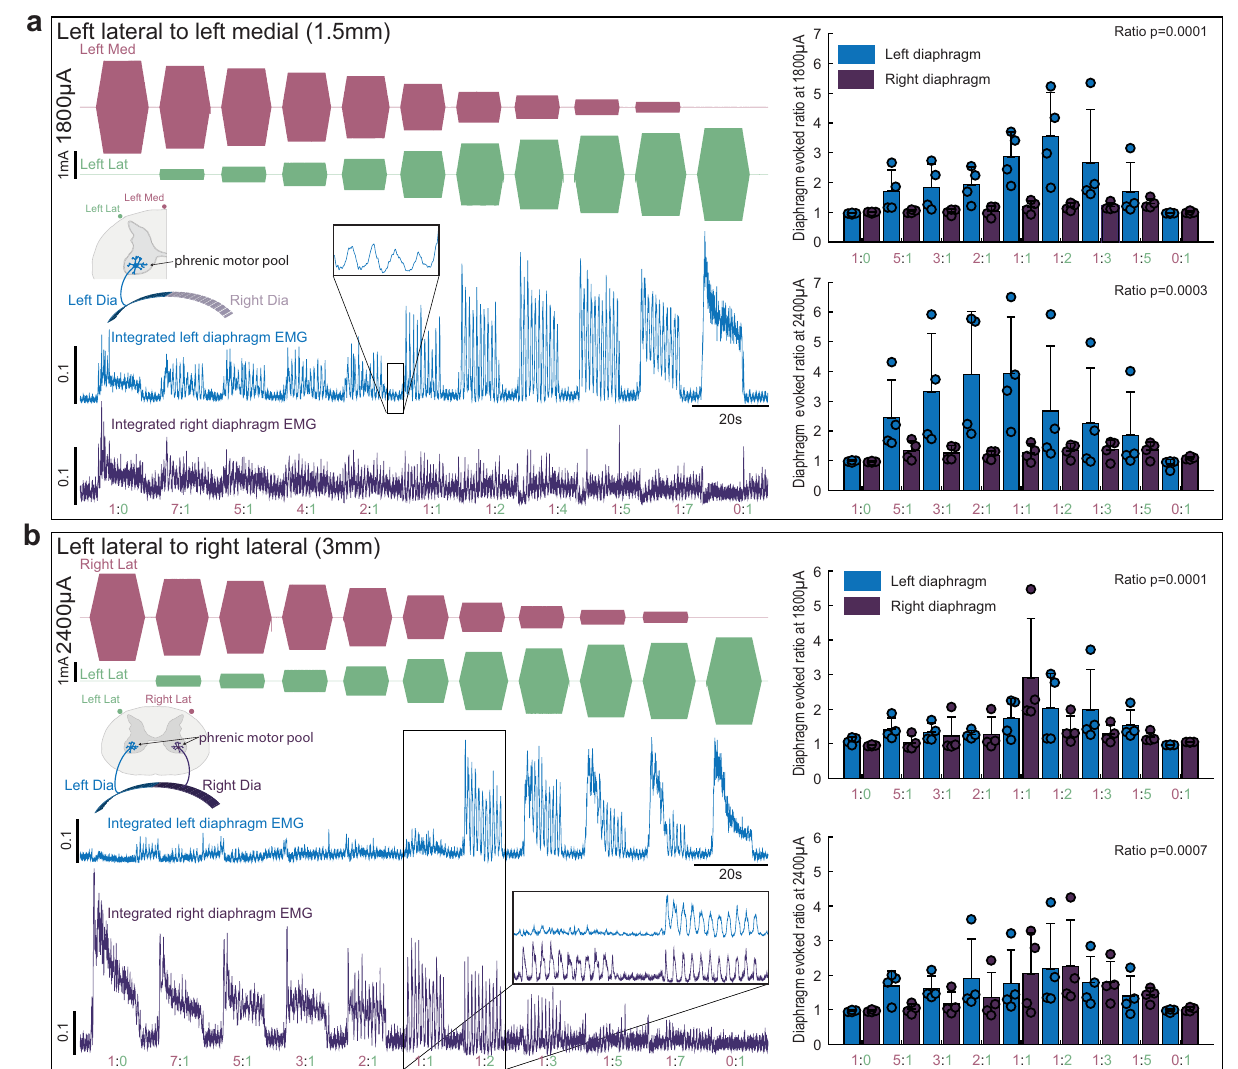
Fig. 4 Current steering during epidural TI stimulation. Using diaphragm EMG as the outcome measure, the steerability of the TI focal point was examined by varying the ratio of the two stimulus currents using two inter-electrode distance. Stimulating electrodes were placed on the left side of the spinal cord ( a , 1.5 mm apart) or spanning the dorsal surface ( b ; 3 mm apart). The left side of panel a shows an example of recti fi ed and integrated diaphragm activity when TI was delivered with lateral electrode placement and a current sum of 1800 µ A. In this example it can be appreciated that varying the TI current ratio dramatically alters the magnitude of phasic diaphragm activation, and tonic diaphragm activation occurs at current ratios of 1:0 and 0:1. The mean data (right panels) show a statistical effect of current ratio at currents sums of 1800 µ A (Friedman ’ s two-way ANOVA controlling for diaphragm side effect of current ratio Chi-squared(8) = 33, p < 0.0001) and 2400 µ A (Friedman ’ s two-way ANOVA controlling for diaphragm side effect of current ratio Chi- squared(8) = 23.96, p = 0.0023). The left side of panel b shows an example of diaphragm activity evoked by stimulating the spinal cord using an inter- electrode distance of 3 mm and a current sum of 2400 µ A. In this example, TI stimulation induced a robust bilateral and phasic diaphragm EMG activation at a current ratio of 1:2. The mean data show an effect of current ratio at sum current of 1800 µ A (Friedman ’ s two-way ANOVA controlling for diaphragm side effect of current ratio Chi-squared(8) = 29.33, p = 0.00003) and at 2400 µ A (Chi-squared(8) = 26.99, p = 0.00007). Note we lowered inspired CO 2 to reduce endogenous diaphragm activity during these trials, small bursts are still present (inset panel a ), but at much lower amplitude than the TI-evoked bursts ( n = 4